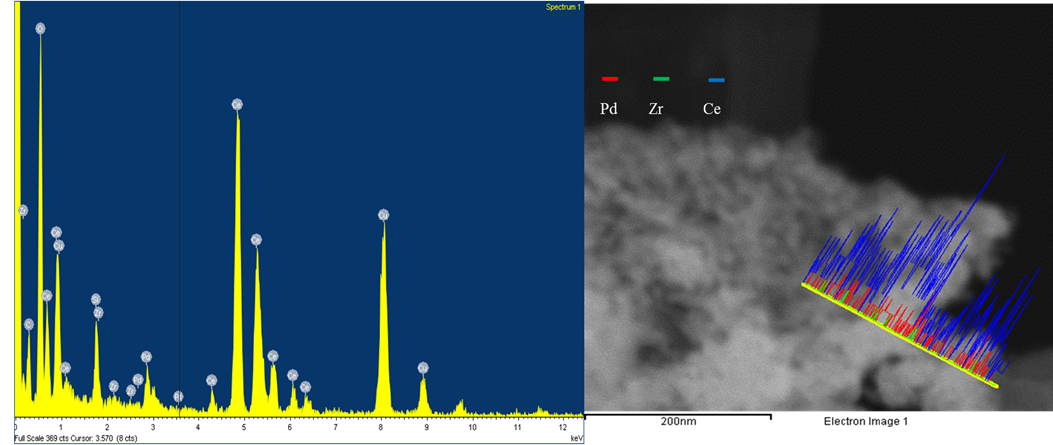
Figure 2. STEM-EDX spectrum with elemental compositions line scan of Ce 1-(x+y) Zr x Pd y O 2-δ . This illustrates the abundance of elements in the sample across the selected area, marked by the yellow line, and the distribution of Ce, Pd and Zr. The line scan is characterised by a high Ce